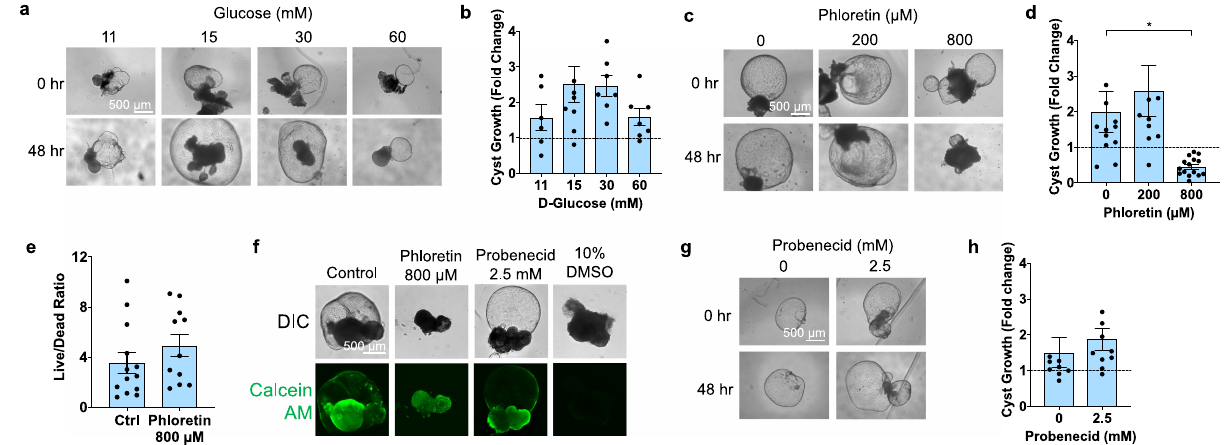
Fig. 4 | PKD cysts expand in response to glucose stimulation. a Representative time lapse bright fi eld images and ( b ) quanti fi cation of change in cyst size in PKD organoids in static suspension cultures containing with D-Glucose concentrations (mean±s.e.m., n ≥ 6 pooled from four independent experiments, each dot indi- cates a single cyst). c Representative time lapse images and ( d ) quanti fi cation of PKD organoids in 15mM D-Glucose treated with phloretin (mean±s.e.m., n ≥ 10 cysts pooled from four independent experiments, p =0.0231). e Quanti fi cation of